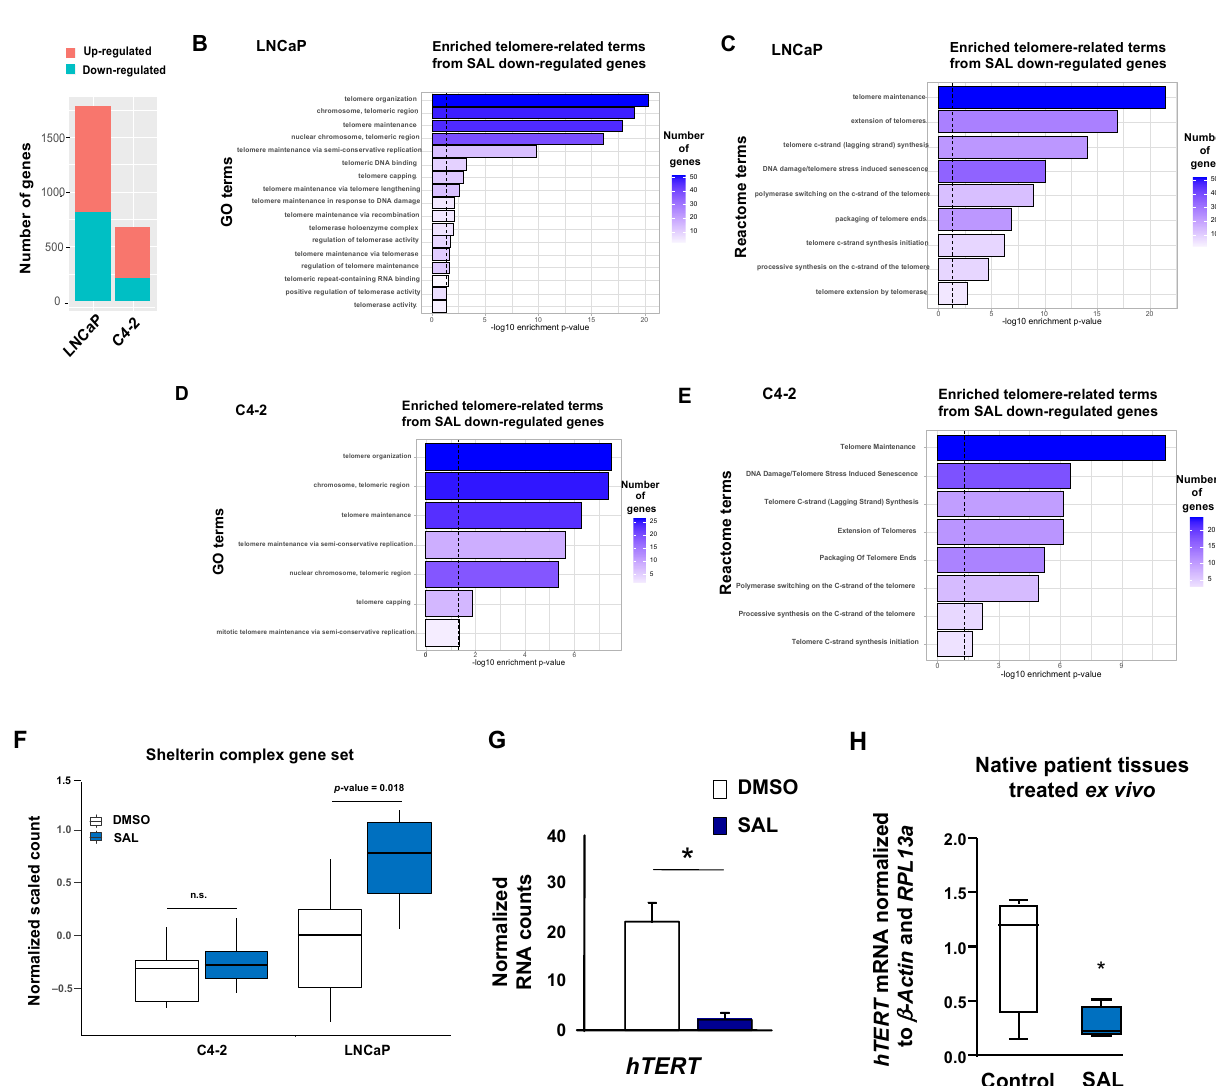
Figure 1. Transcriptome analyses reveal a significant enrichment of telomeric Gene Ontology, Reactome terms, and shelterin complex subunits. The androgen-sensitive LNCaP or the castration-resistant C4-2 human PCa cells were treated with SAL (1 nM R1881) or solvent treated control (DMSO) 72 h prior to the isolation of RNA and performing RNA-seq. Transcriptome data were analyzed bioinformatically comparing SAL treated with solvent control-treated cells. ( A ) Number of differentially expressed genes (DEGs) including the number of upregulated and downregulated genes in both LNCaP and C4-2 cells. The telomere-related downregulated genes exhibit a stronger response to androgen treatment in LNCaP cells considering both the number of DEGs and the intensity of change (log2 fold). Indicated are SAL-mediated down-regulated genes significantly enriched in telomere-related GO and Reactome terms in LNCaP ( B , C ) and C4-2 ( D , E ) cells. ( F ) Gene set enrichment analysis (GSEA) of telomere-related genes, the subunits of the shelterin complex, upon SAL treatment compared with DMSO. Error-bars represent SEM. Wilcoxon paired test (gene-wise comparison, two-tailed) is used for p -value calculation. ( G ) mRNA expression of hTERT in LNCaP cells treated with the solvent control DMSO or SAL. Normalized RNA counts are indicated with the values for DMSO as the control. Adjusted p -value (* p < 0.05) was calculated using the DeSEQ2. ( H ) Native PCa tissue pieces obtained from patients with radical prostatectomy were treated ex vivo with R1881 at SAL as described previously (8). RT-qPCR was used to detect the regulation of hTERT expression by SAL. n = 4, one-tailed student t -test, * p -value: 0.028, n.s.: not